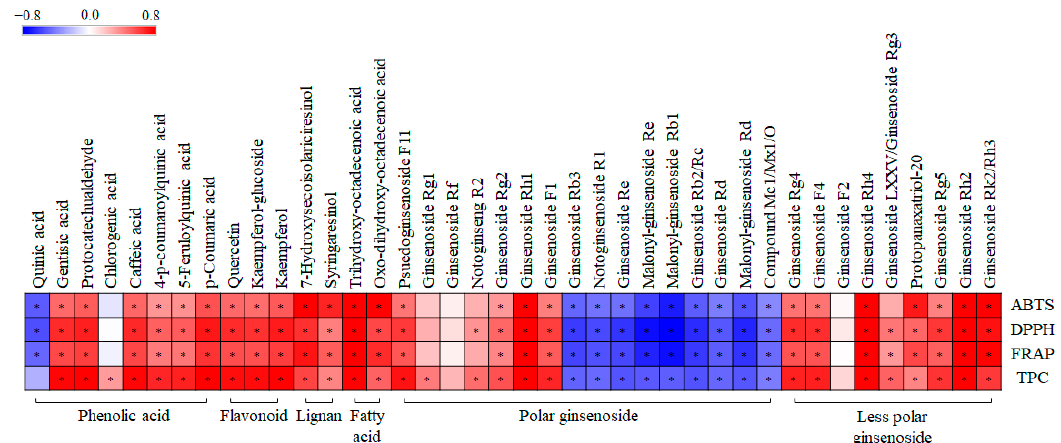
Figure 8. Correlation map between relative abundance of significantly discriminant metabolites and antioxidant assay (ABTS, DPPH, and FRAP), and total phenolic content (TPC) of different solvent fractions of GBP samples. Each square indicates Pearson’s correlation coefficient values (r). Red and blue represent positive (0 < r < 0.8) and negative ( − 0.8 < r < 0) correlations, respectively. *: p -value < 0.05.